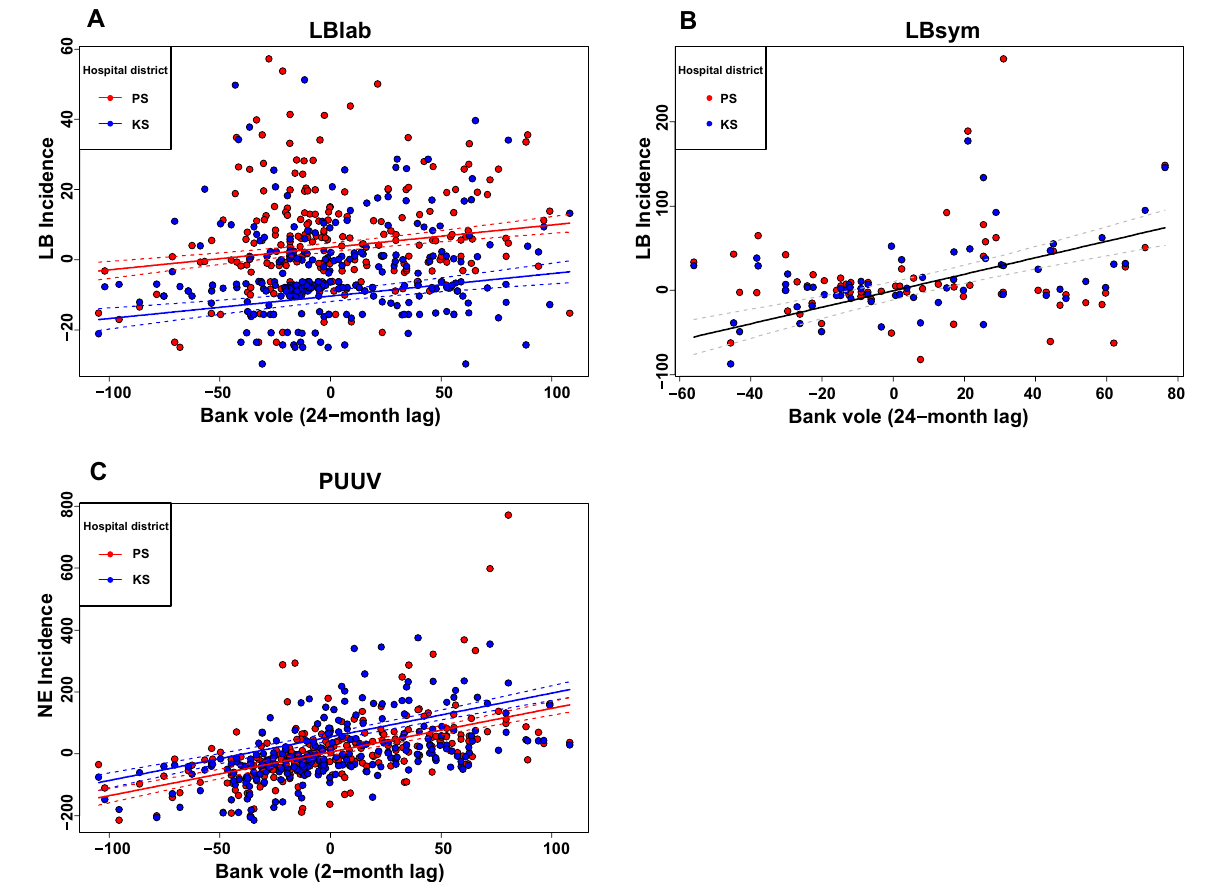
Figure 3. Incidence of LB laboratory ( A ), LB symptoms ( B ) and PUUV infection ( C ) in relation to bank vole abundance 24 ( A , B ) and 2 ( C ) months earlier. Points indicate observations from Central Finland (KS; blue symbols) and Northern Savo (PS; red symbols) hospital districts. Fitted regression lines (unbroken lines) and their 95% confidence intervals (dashed lines) based on linear mixed-effect models are also presented, separately for the two hospital districts (blue lines for Central Finland; red lines for Northern Savo) when there was a hospital district effect ( A , C ) and for pooled data (black line) when hospital district effect was not found ( B ). All the time series were de-seasonalized (see text for details). The coefficients used in drawing the regression lines are presented in Tables 1 and 2. In each plot, lines are drawn for the year 2018 by keeping bank vole abundance 12 ( A ) or 10 ( B ) months earlier fixed at zero (i.e. at the month-specific mean), the slopes of the regression lines being independent of year and bank vole abundance with the 12- and 10-month lags. Figure created by using R version 3.5.3 58